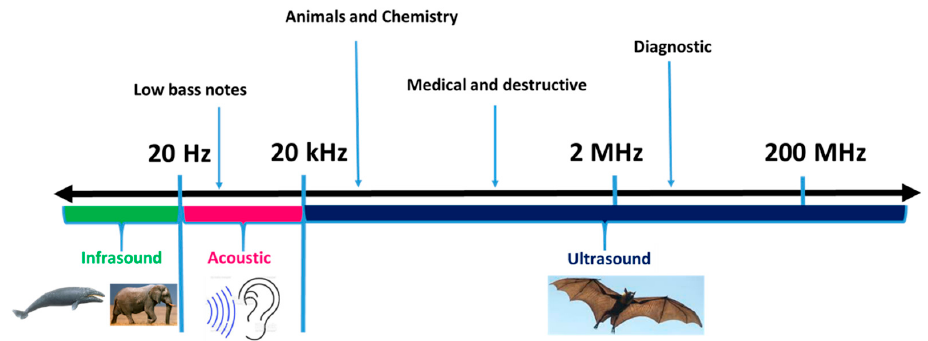
Figure 1. Classification of Ultrasound.